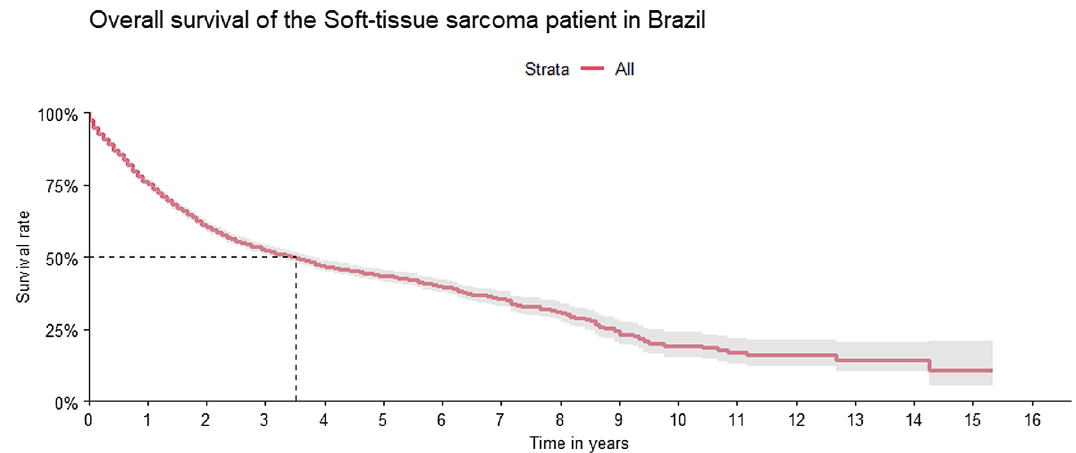
Figure1. Overall Survival of the Soft-tissue Sarcoma Patient in Brazil (only staged and graded